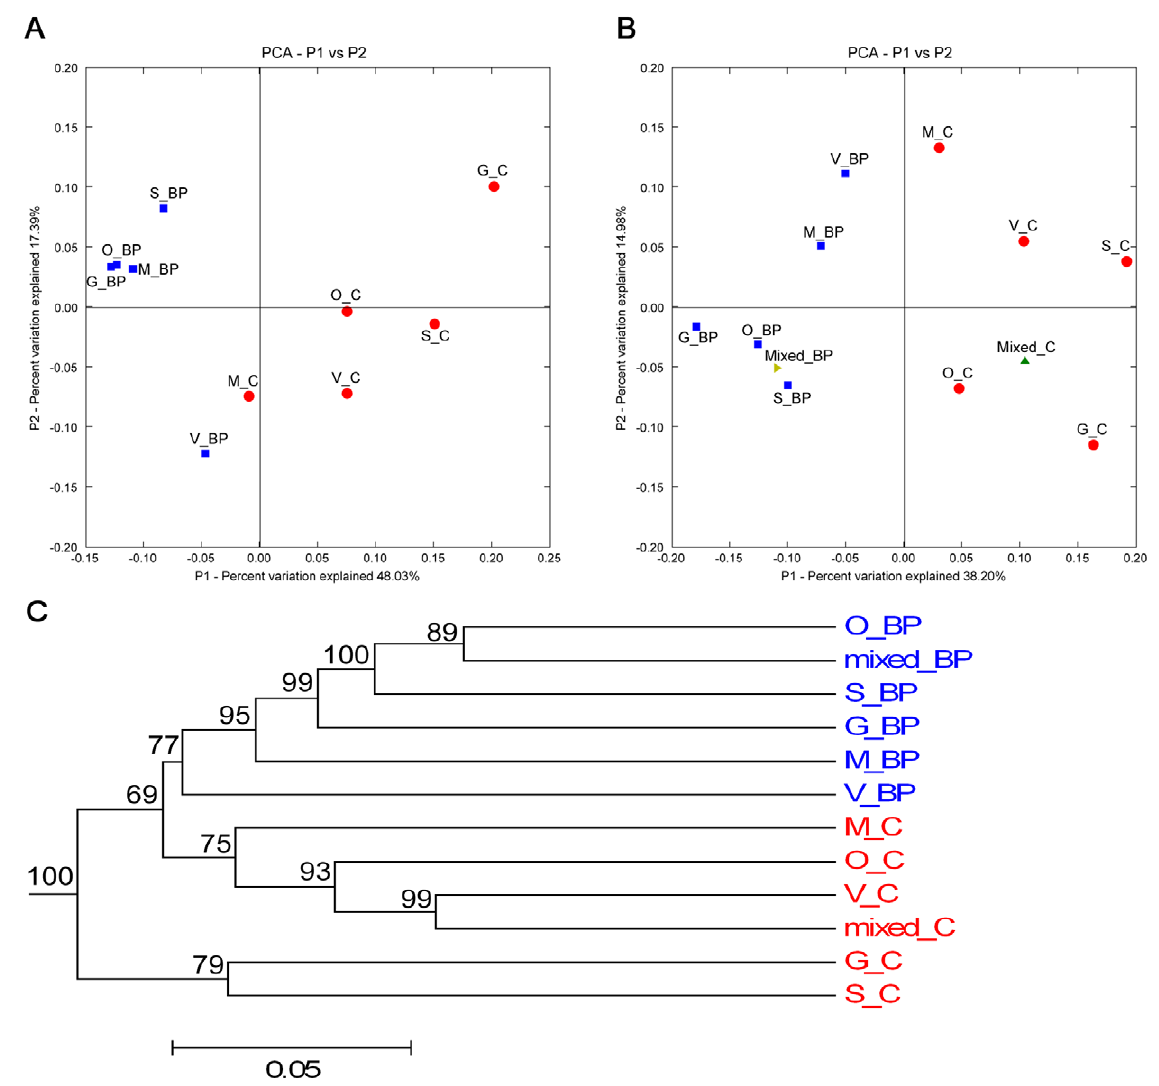
Figure 4. UniFrac analysis of V3 16S sequences from canine fecal samples. ( A ) Principal Component Analysis scatter plot of individual samples by dietary treatment (control = red circles; beet pulp supplemented = blue squares). ( B ) Principal Component Analysis scatter plot of individual samples combined with pooled DNA samples (pooled control = green triangle; pooled beet pulp = gold triangle). ( C ) A jackknifed clustering of the environments in the UniFrac dataset (100 permutations). The numbers next to the nodes represent the number of times that particular node was observed (out of 100) in a random sampling from the whole dataset.